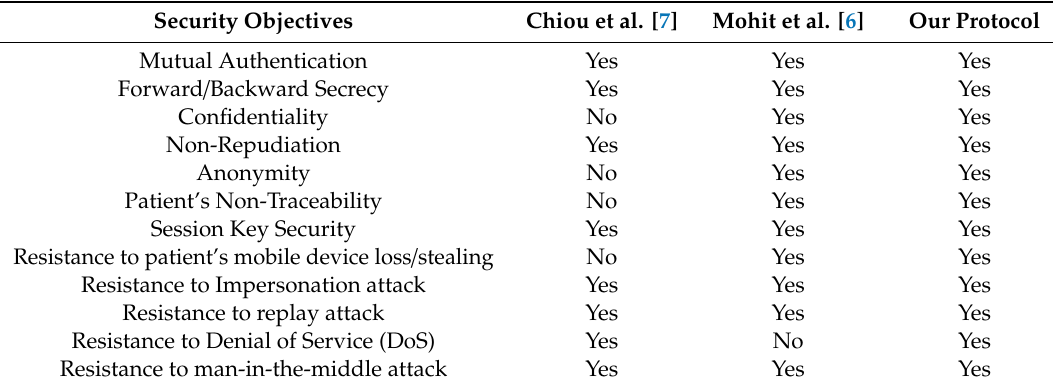
Table 3. Comparison of security objectives among protocols.